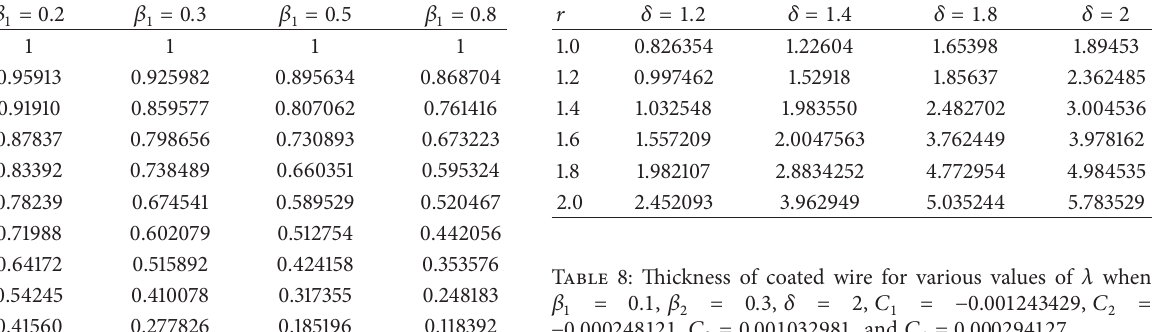
Table 7: Thickness of coated wire for various values of 𝛿 when = 𝛽 3